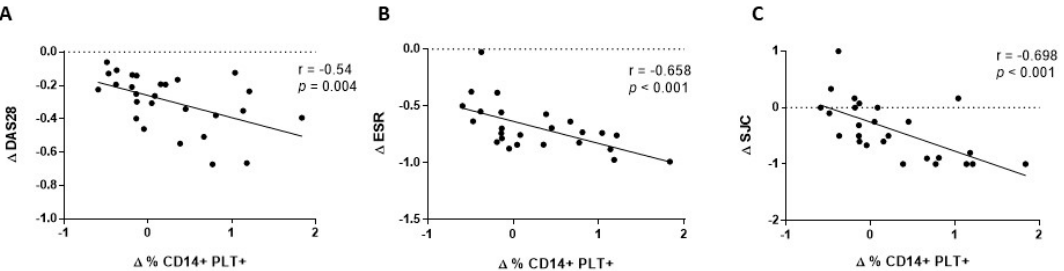
Figure 4. Association of changes in monocytes with bound platelets and CD162 expression on monocytes after 4 weeks of tocilizumab treatment with clinical and laboratory parameters. ( A ) Changes in percentage of monocytes with bound platelets (CD14+PLT+) correlation with changes in DAS28, ( B ) ESR and ( C ) swollen joint count (SJC). Statistical analysis was performed using the Spearman’s correlation.